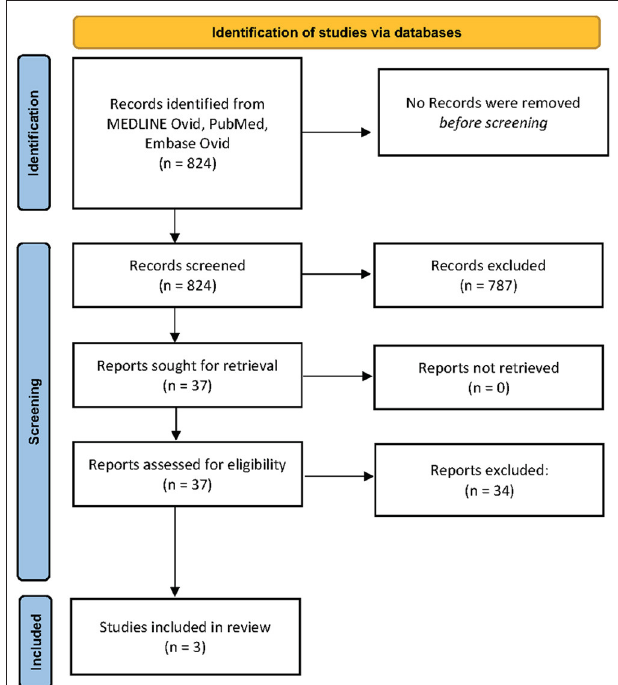
FIGURE 1 | PRISMA flow diagram. From: Page et al.